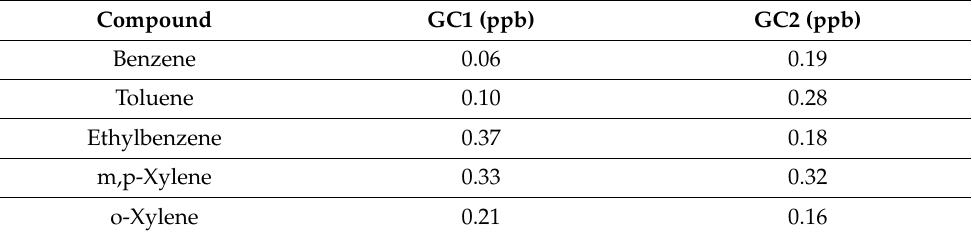
Table 3. BTEX detection limits for each BTEX GC-PID instrument referred to as GC1 and GC2. Compound